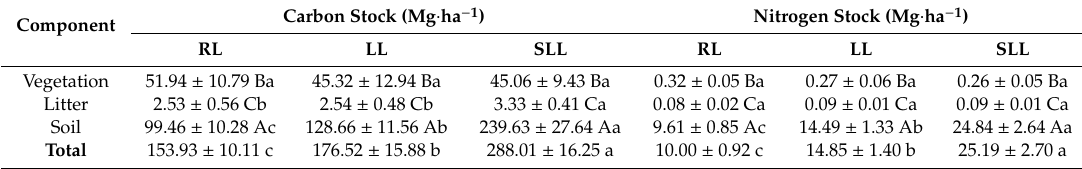
Table 10. Ecosystem carbon and nitrogen stocks in the three types of larch forest ecosystems. Component